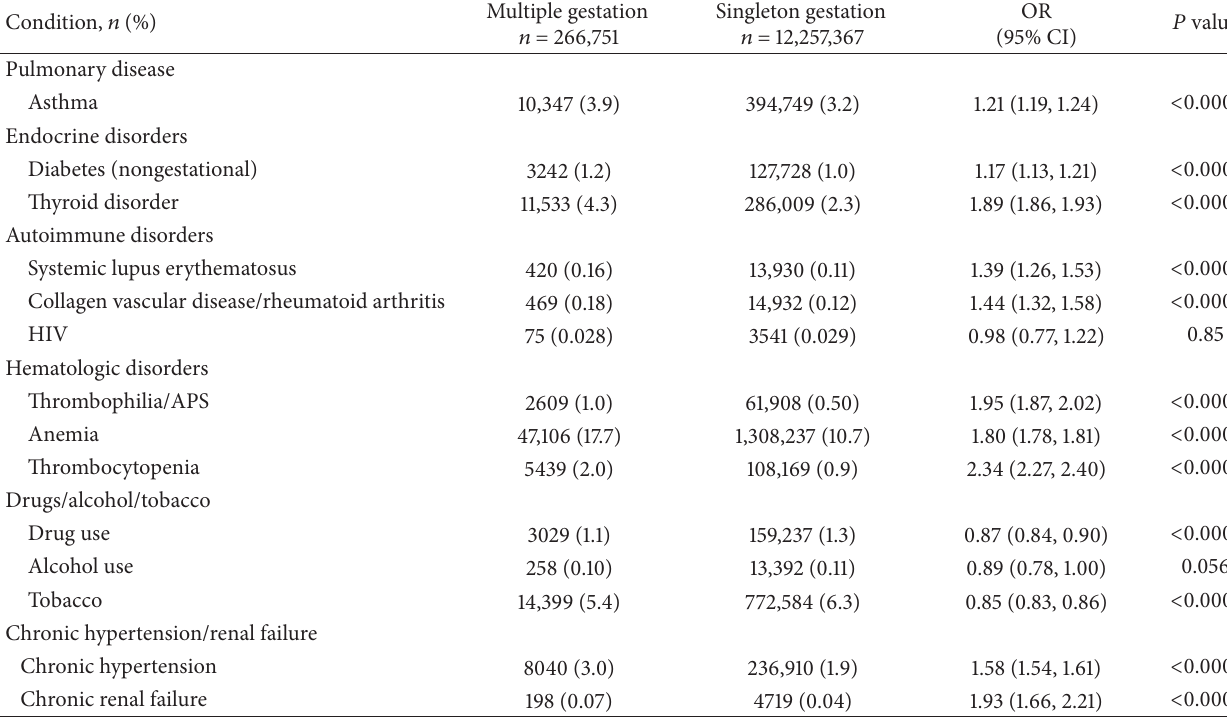
Table 2: Preexisting medical conditions present during hospital discharges for delivery among pregnant women with multiple gestation compared to women with singleton gestation, Nationwide Inpatient Sample for years 2008–2010 (12,524,118 deliveries).